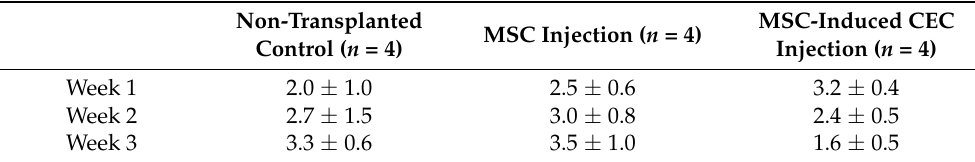
Figure 4. Slit-lamp microscope image of the healthy group, non-transplanted control group, MSC injection group, and MSC-induced CEC injection group at 1, 2, and 3 weeks after cell transplantation. ( A ) The MSC-induced CEC injection group exhibited a lower corneal opacity score than the non-transplanted control group at 3 weeks, showing less neovascularization than the MSC injection group. ( B ) Corneal opacity score over time. The MSC-induced CEC injection group had the lowest corneal opacity score at 3 weeks after cell transplantation. (* p < 0.05). Table 1. Mean corneal opacity score for each group at weeks 1, 2, and 3.